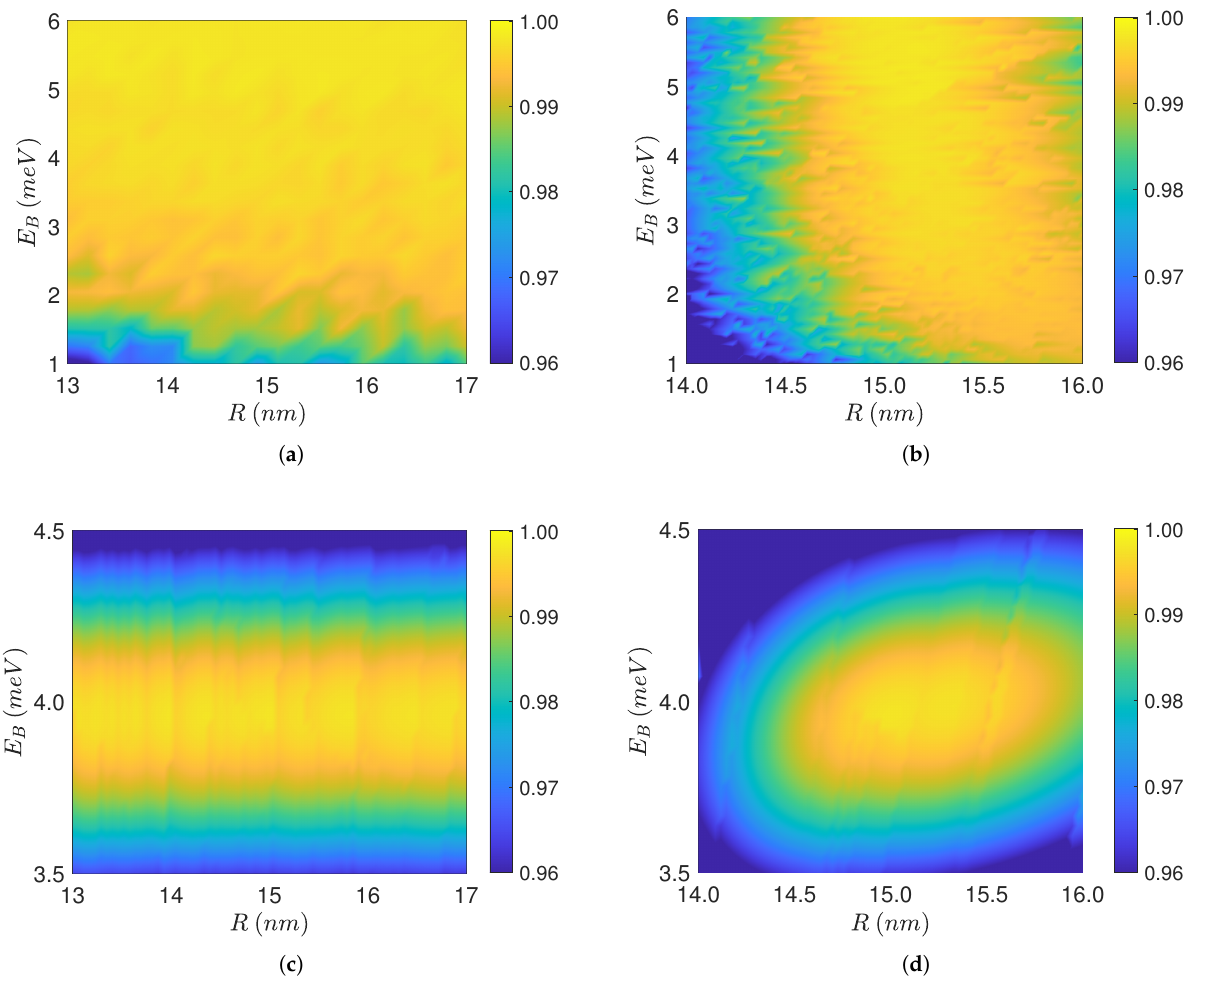
Figure 6. ( a ) Final value of the population σ 22 ( T ) from the numerical solution of Equation (6) using the pulse-sequence obtained for each pair of values ( E B , R ) in the range shown. ( b ) σ 22 ( T ) for the pulse timings obtained with the fixed reference value R 0 = 15 nm and variable E B , when applied to system Equation (6) with variable R in the range R 0 ± 1 nm = 4 meV and variable and the corresponding E B . ( c ) σ 22 ( T ) for the pulse timings obtained with the fixed reference value E 0 B ± 0.5 meV and the corresponding R . ( d ) σ ( T ) for the R , when applied to Equation (6) with variable E B in the range E 0 22 B = 4 meV, when applied to Equation (6) with variable R in the range pulse-sequence obtained with fixed R 0 = 15 nm and E 0 B ± 0.5 R 0 ± 1 nm and E B in the range E 0 B